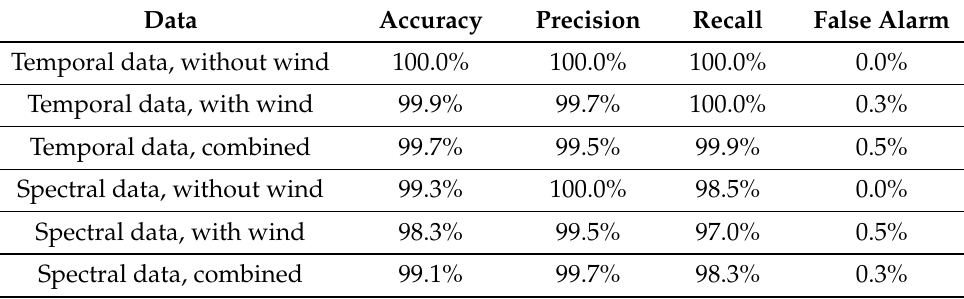
Table 2. Summary of the CNN’s performance for the various environmental